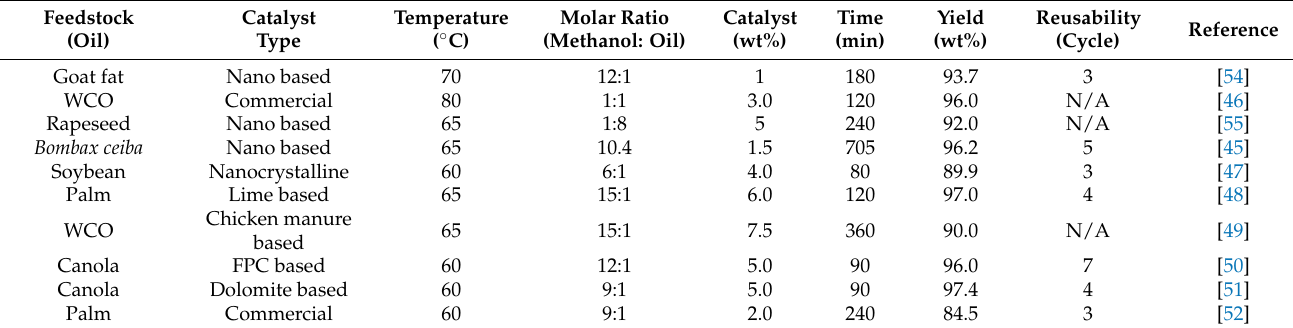
Table 2. Pure CaO-based catalysts type and the reaction conditions in biodiesel production. Feedstock (Oil) Goat